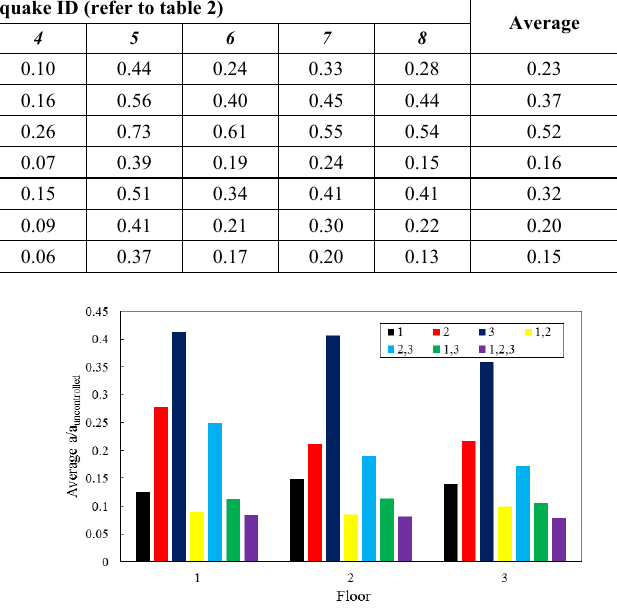
Figure 5. Comparing controlled and uncontrolled displacement at different floors for different dampers’ arrangements under Kobe Earth- quake.